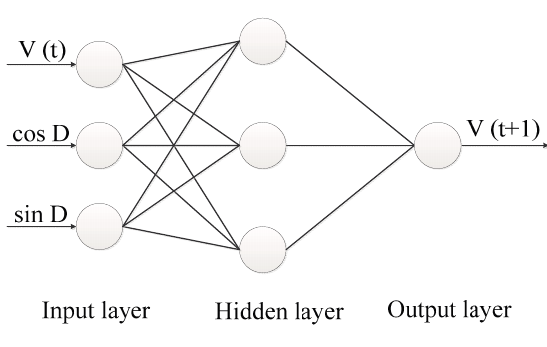
Figure 5. Three-layer BP neural